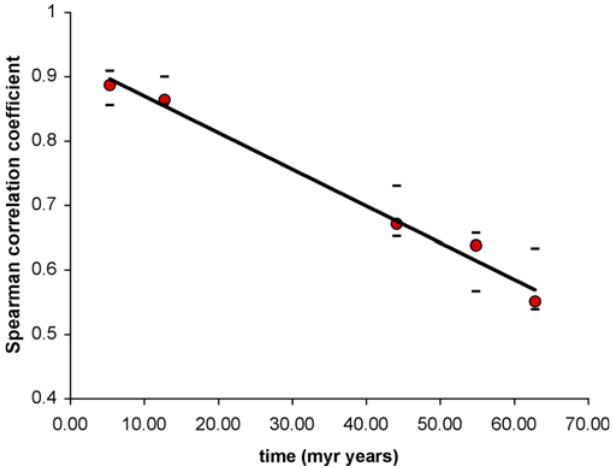
Figure 9. Intron Lengths Can Be Used as a Molecular Clock y -axis, magnitude of the Spearman correlation coefficient for the five Drosophila distributions shown in Figure 8. x -axis, time (millions of years) since last common ancestor based on protein similarities as calculated in [30]. Black bars above and below each data point denote observed variance in the data and were obtained by randomly resampling 1,000 orthologous intron pairs 100 times. Best-fitting curve (shown in black)